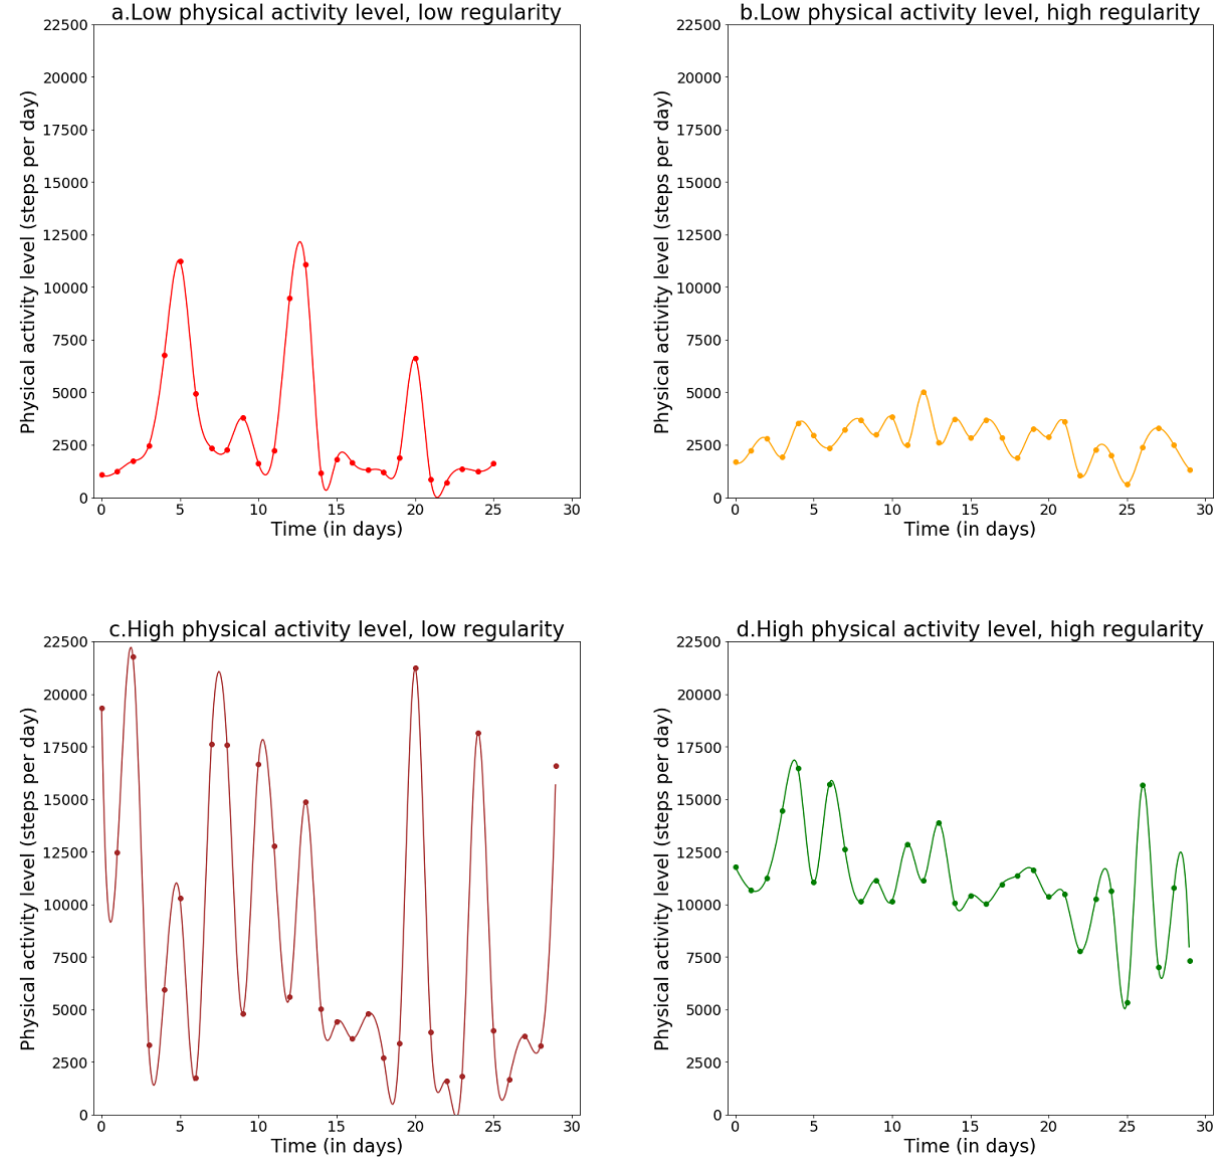
Figure 2. Real-word examples of evolution of physical activity (PA) level within the first 30-day period of the use of a wearable activity tracker. (a) Mean PA level=3223 steps per day; PA level coefficient of variation (CV)=98%. (b) Mean PA level=2720 steps per day; PA level CV=34%. (c)